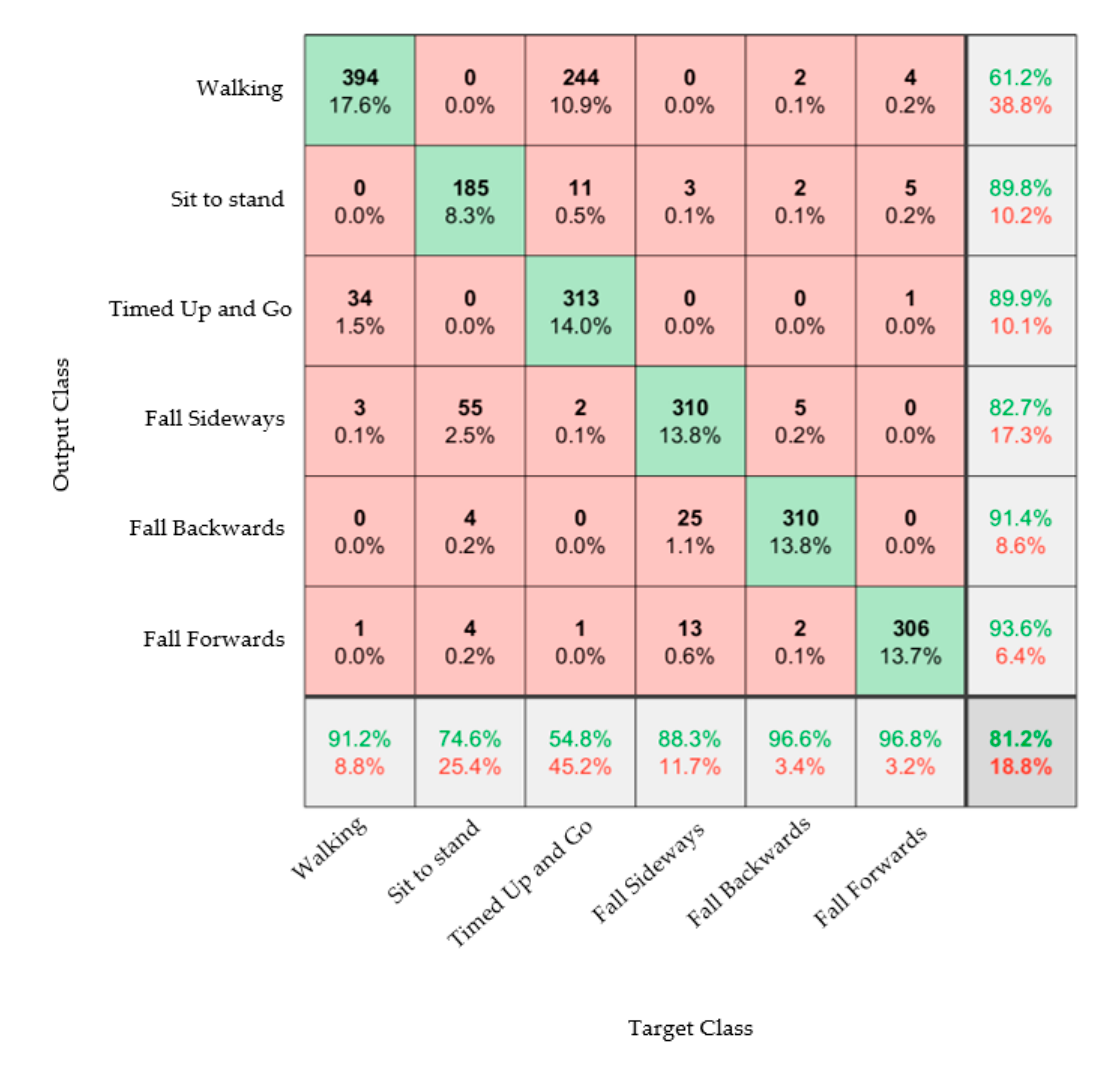
Figure 6. Confusion matrix showing the results of the classification of the three ADL activities and three fall activities.